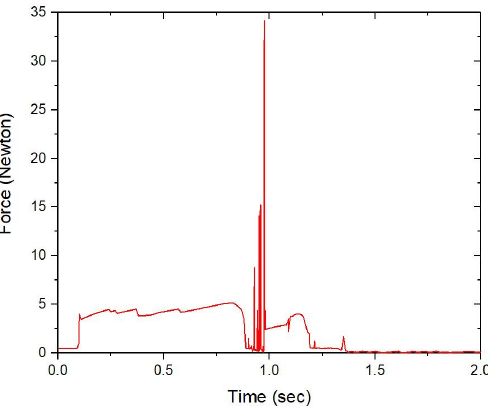
Figure 17 . The robot’s movement speed at a 300 mm turning radius. Figure 17. The robot’s movement speed at a 300 mm turning radius.